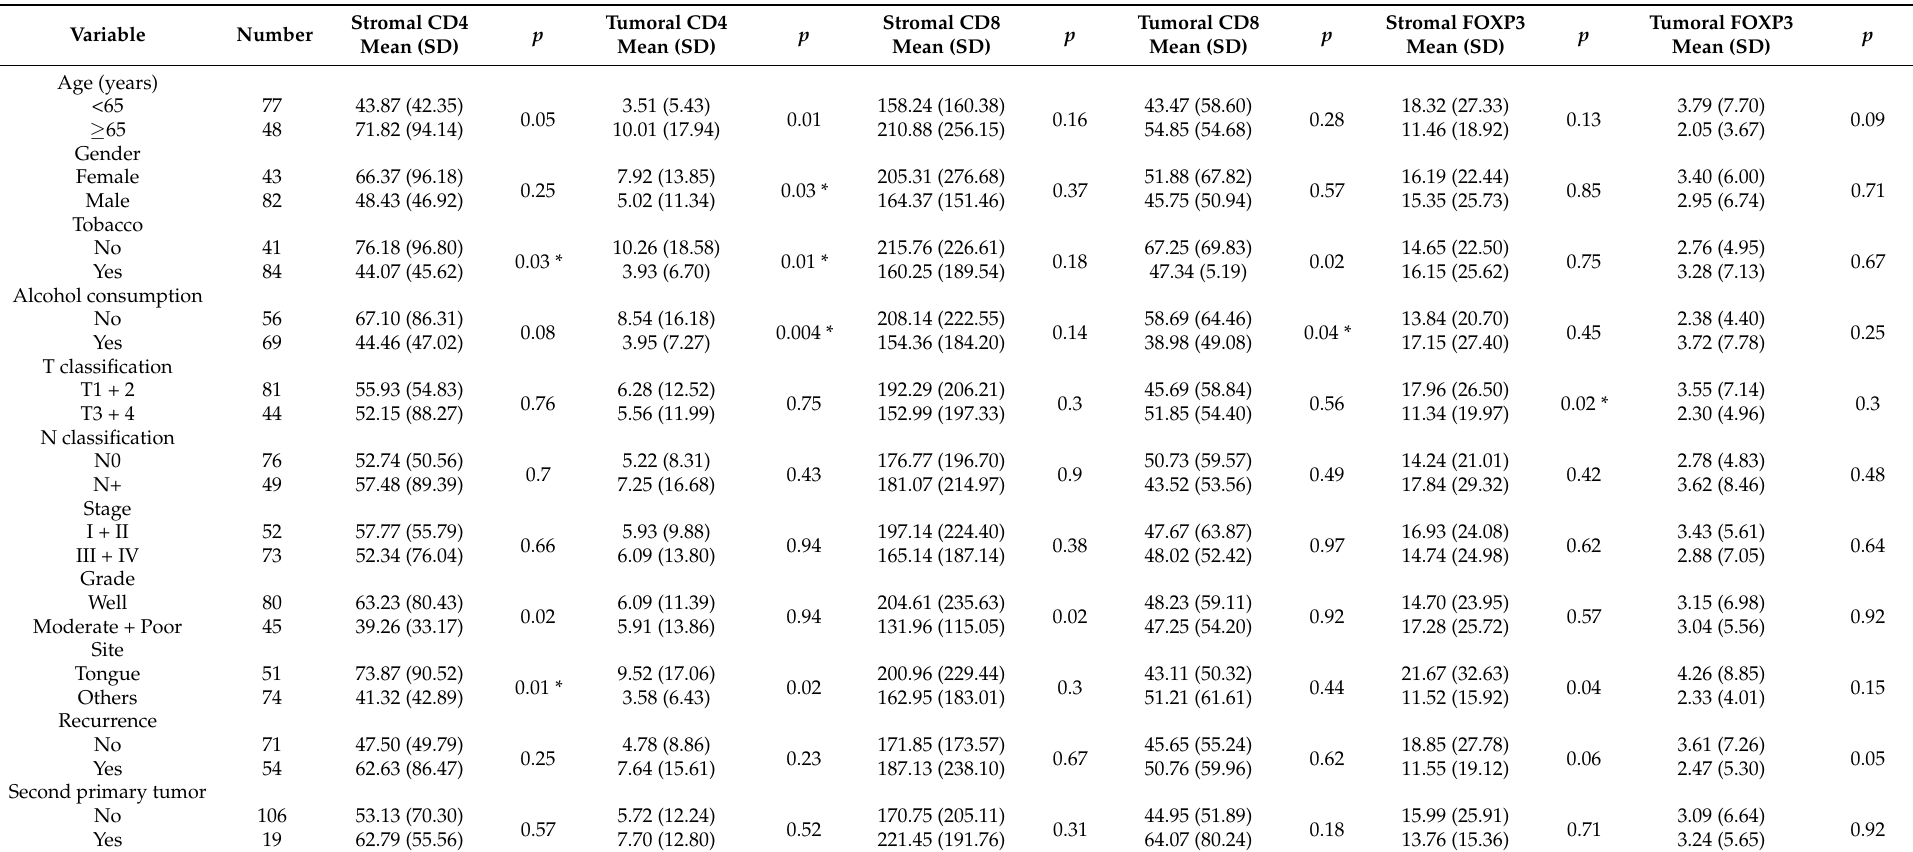
Table 1. Associations between stromal and tumoral CD4, CD8 and FOXP3 TILs and the clinicopathological parameters in the cohort of 125 OSCC